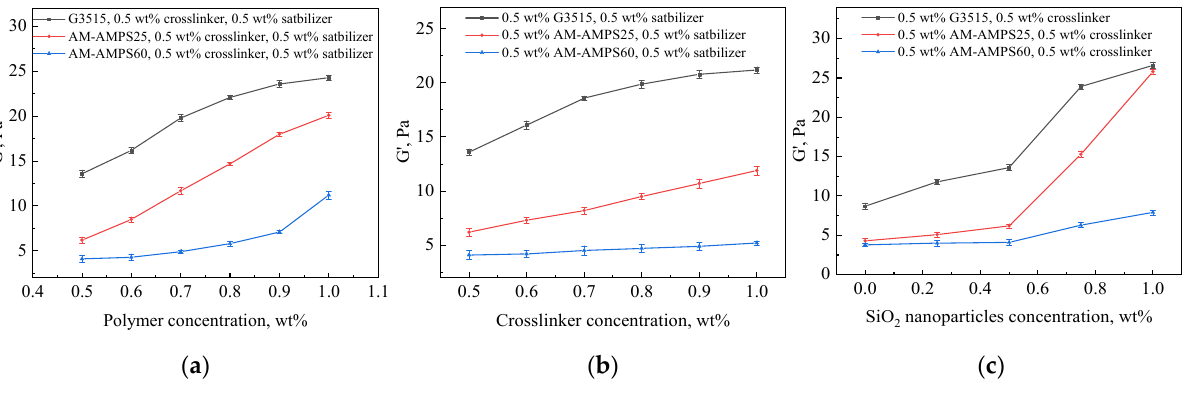
Figure 4. Gel storage modulus (G’) of gels prepared with different polymers. ( a ) Effect of polymer concentration on G’ of gels; ( b ) Effect of crosslinker concentration on G’ of gels; ( c ) Effect of SiO 2 nanoparticles concentration on G’ of gels.